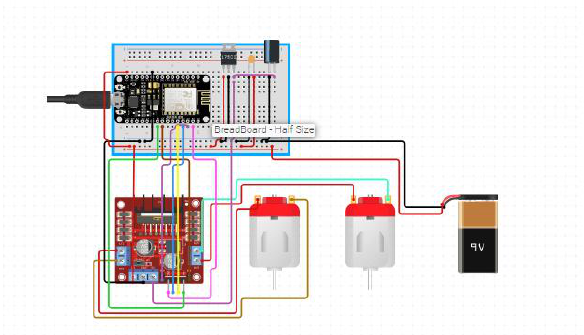
Fig 6. Rover controller